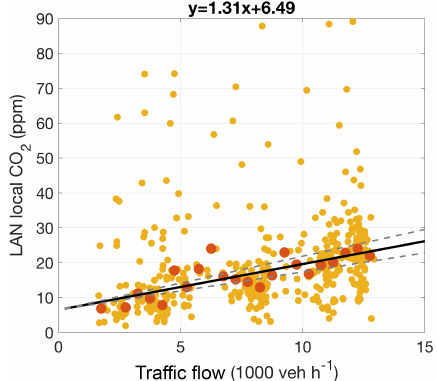
Figure 6. Morning (04:00–08:00LT) local summertime CO 2 con- centrations at LAN shown as a function of nearby highway traf- fic flow. Darker points indicate the median CO 2 concentration ob- served in each 500vehiclesh − 1 traffic flow increment; black solid line indicates the linear regression through the binned medians (equation given above plot), and gray dashed lines show the un- certainty in the regression